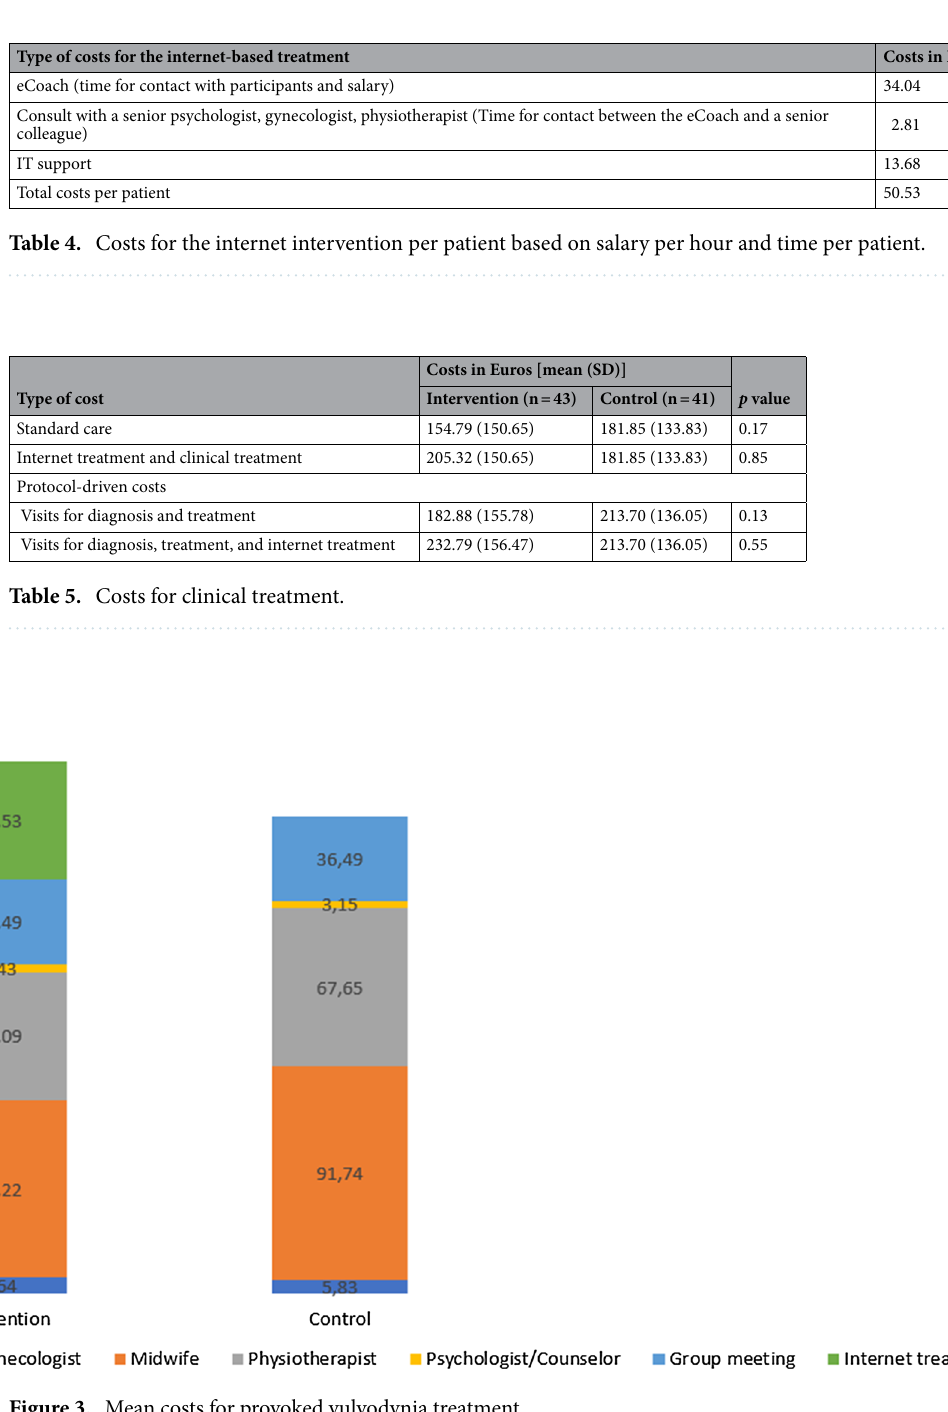
Figure 3. Mean costs for provoked vulvodynia